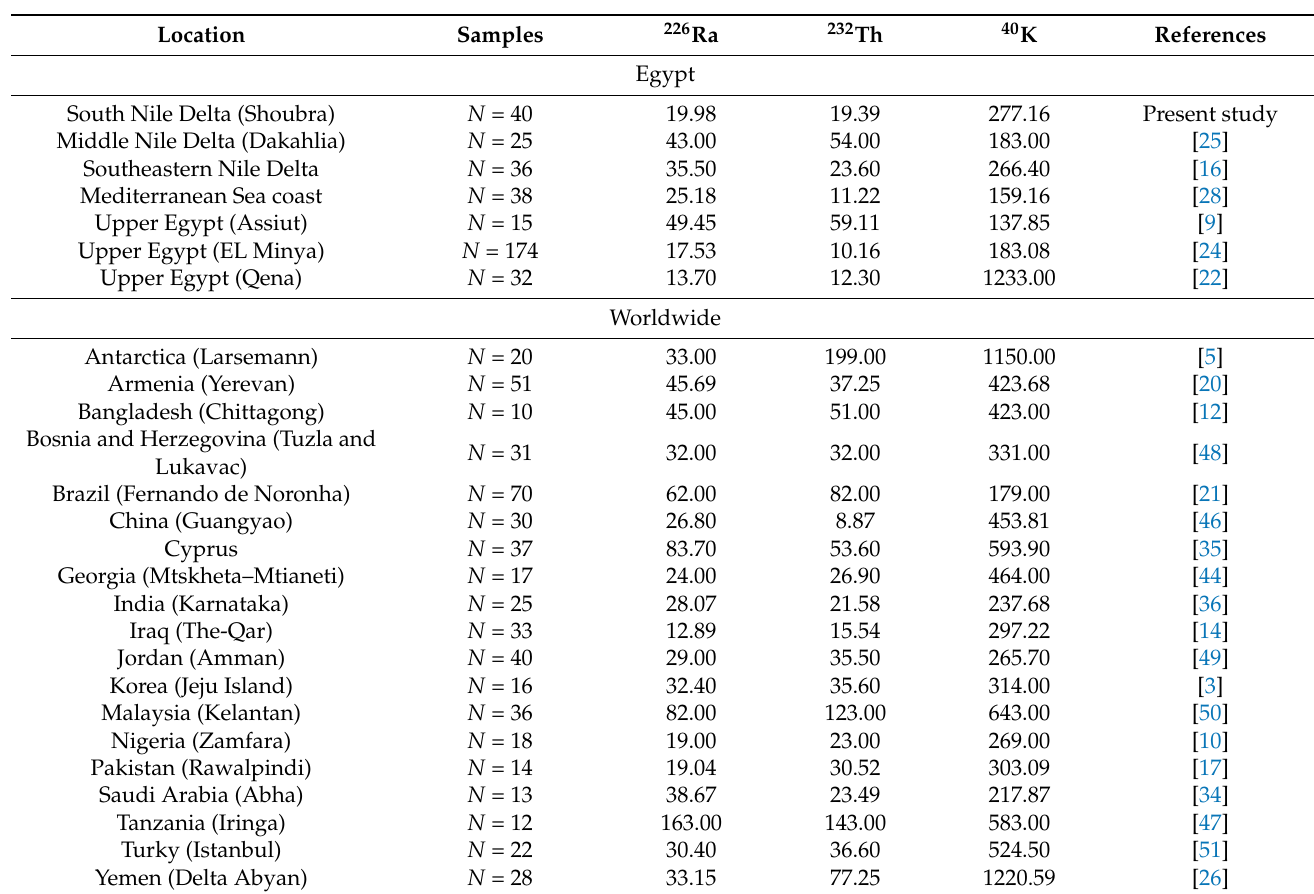
Table 3. Comparison of 226 Ra, 232 Th, and 40 K mean activity concentration in soil samples reported for different regions in Egypt and